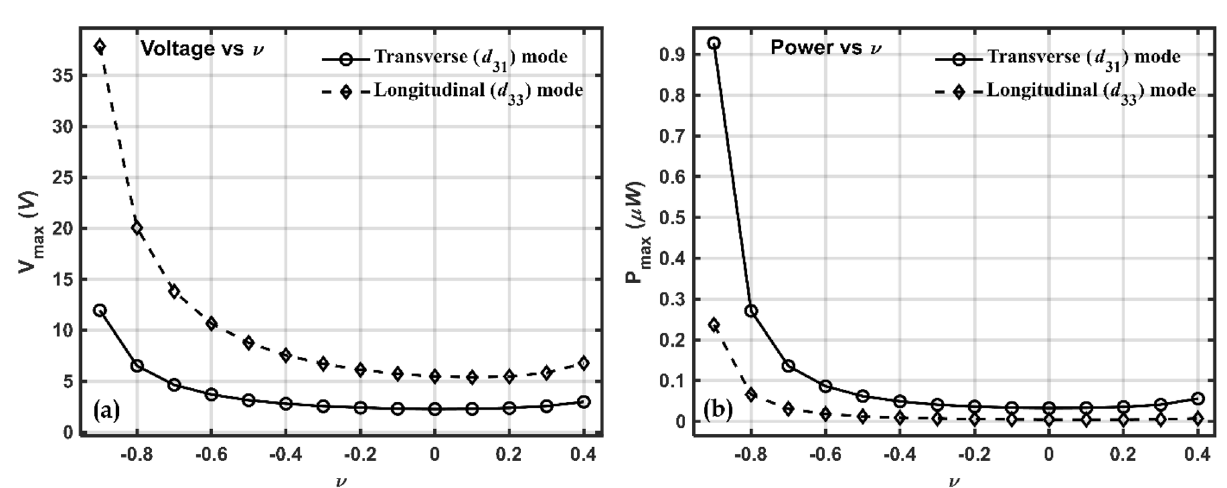
Figure 15. Plot of ( a ) maximum voltage and ( b ) maximum power w.r.t Poisson’s ratio in Transverse ( d 31 ) and Longitudinal ( d 33 )